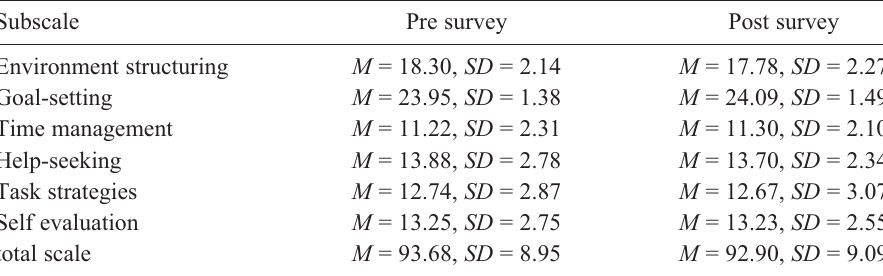
Table 3. Descriptive statistics for each